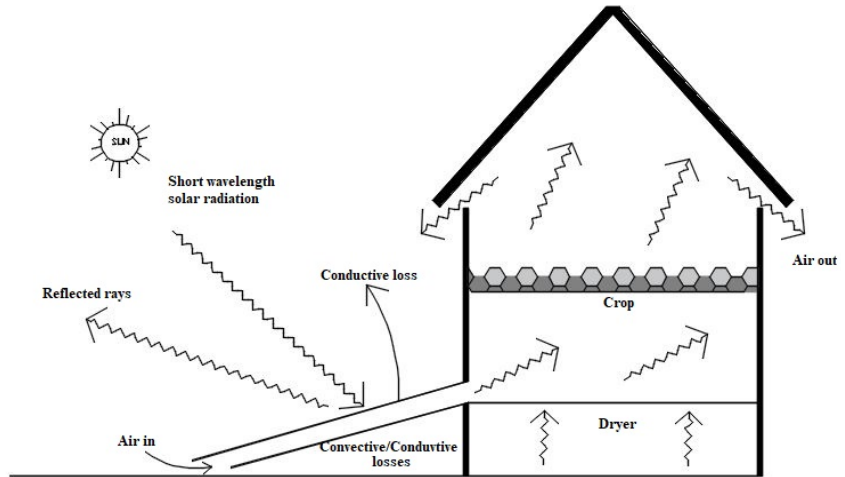
Figure 3. Indirect solar drying